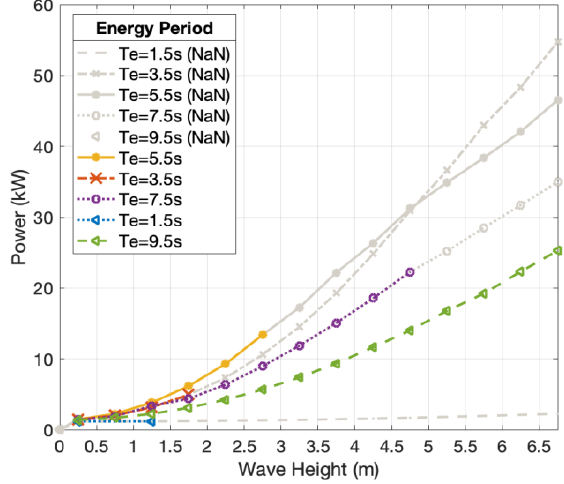
Figure 7. Generated power production from the WEC varies with the significant wave height (five cases of energy periods are chosen). Curves with data in grey are physically non-existed in ocean waves.